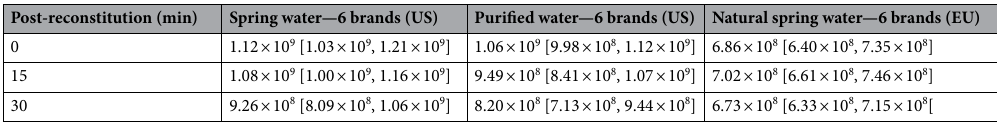
Post-reconstitution (min) Spring water—6 brands